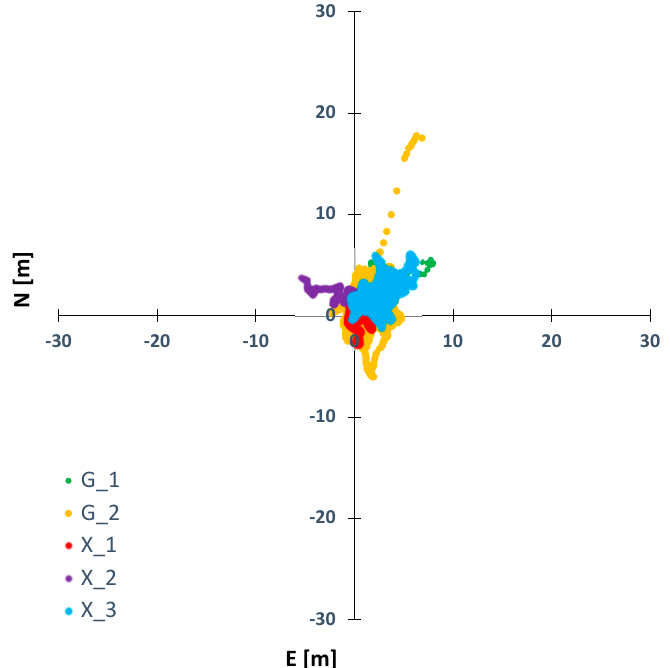
Figure 14. Plot of NE component deviations of static measurements with code receivers.